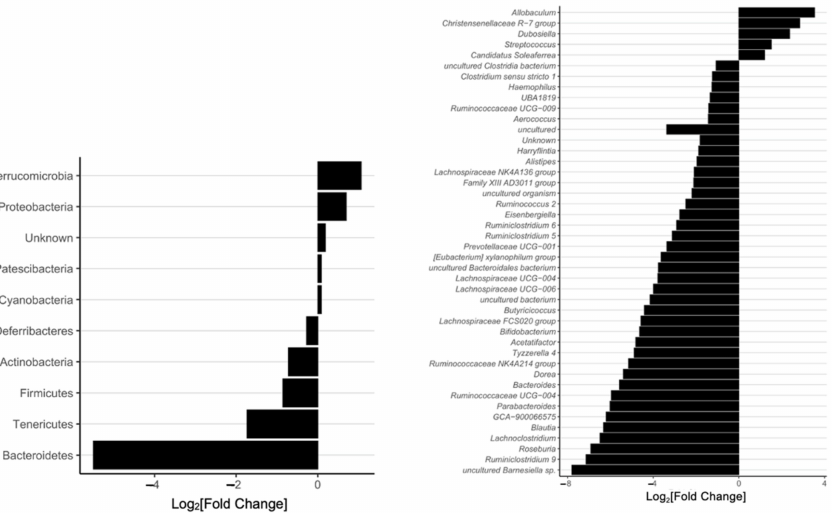
Figure S3. Differential abundance of cecal bacteria at the phylum ( left ) and genus level ( right ) in FC vs. FS treated pups at PD 15. All genera plotted are significantly different between iron groups. Differential abundance was determined using DESeq2 and FDR-adjusted p -values < 0.05 from pairwise group comparisons were considered significant. p -values are listed in Tables S3 and